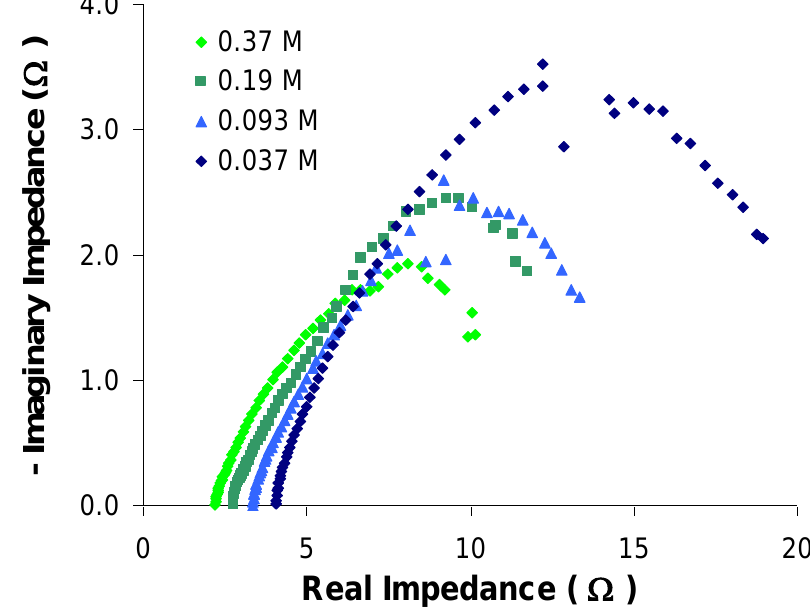
Figure 7. Nyquist plot of varying anode fluid strength experiments.